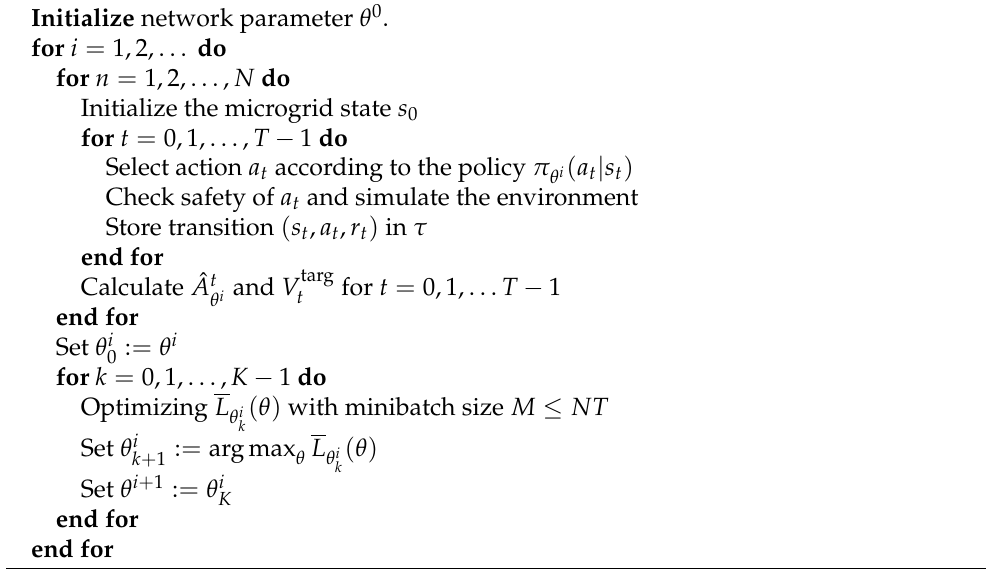
Algorithm 1 The PPO algorithm for microgrid real-time scheduling Initialize network parameter θ 0